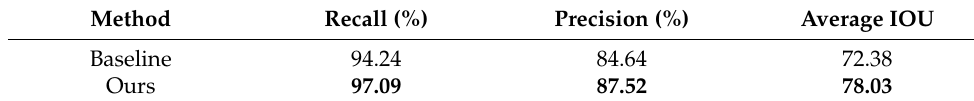
Table 2. Detection effect of our method and baseline model in the same scene.